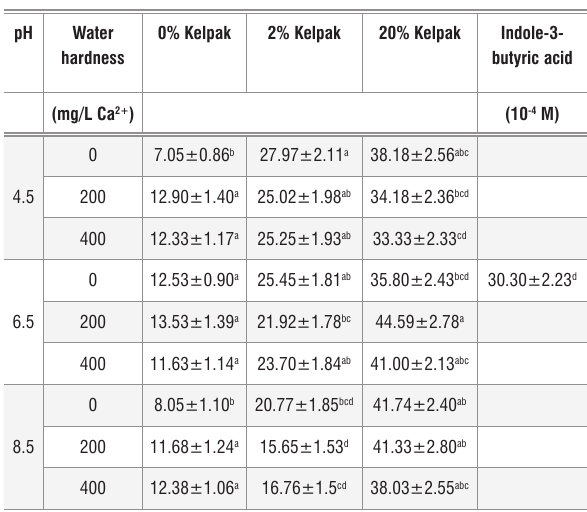
Table 1: Effect of pH and water hardness (Ca 2+ concentration) on the root-promoting ability of 0%, 2% and 20% Kelpak ® solutions applied to mungbean cuttings